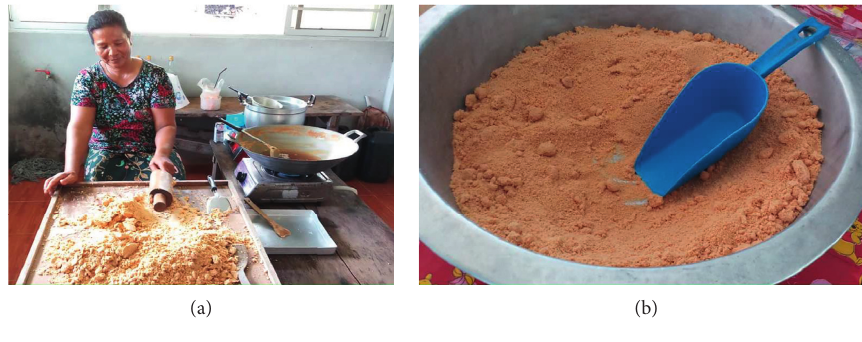
Figure 8: Granulated sugar in Khanap